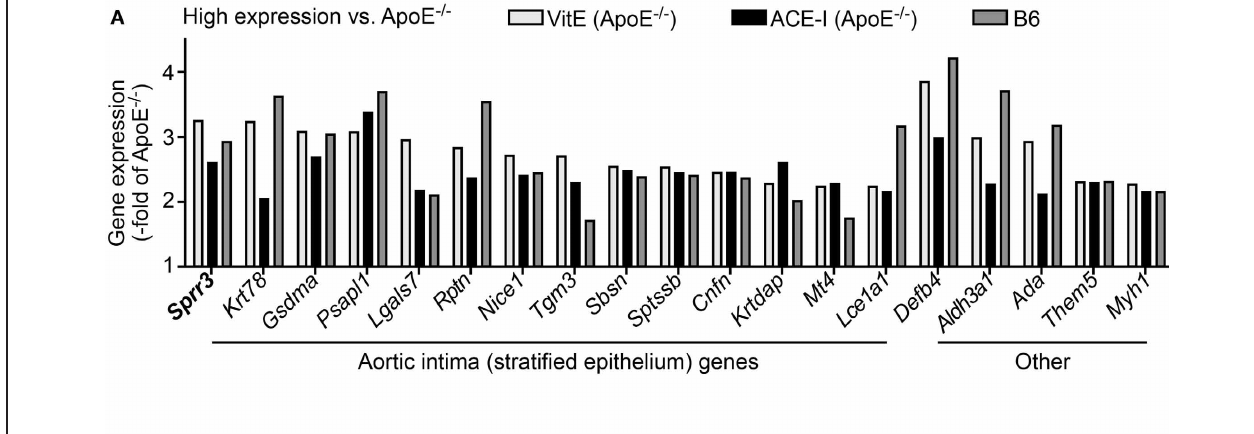
as—fold of untreated ApoE − / − mice. (B) Left panels: immunohistological detection of Sprr3 with anti-Sprr3 antibodies validated microarray data and showed down-regulation of Sprr3 in the aorta of a 34 week-old untreated ApoE − / − mouse relative to an age-matched B6 mouse (upper panels). The Sprr3 protein was preserved by vitamin E treatment and ACE-inhibitor treatment (lower panels). Nuclei were counterstained with hematoxylin, HE (bar: 40 μ m). The right panel shows quantitative evaluation of immunohistology data from four mice each ( ± s.d.; n = 4; a P = 0 . 0029; b P = 0 . 0014; c P = 0 . 0015 vs. ApoE − / −